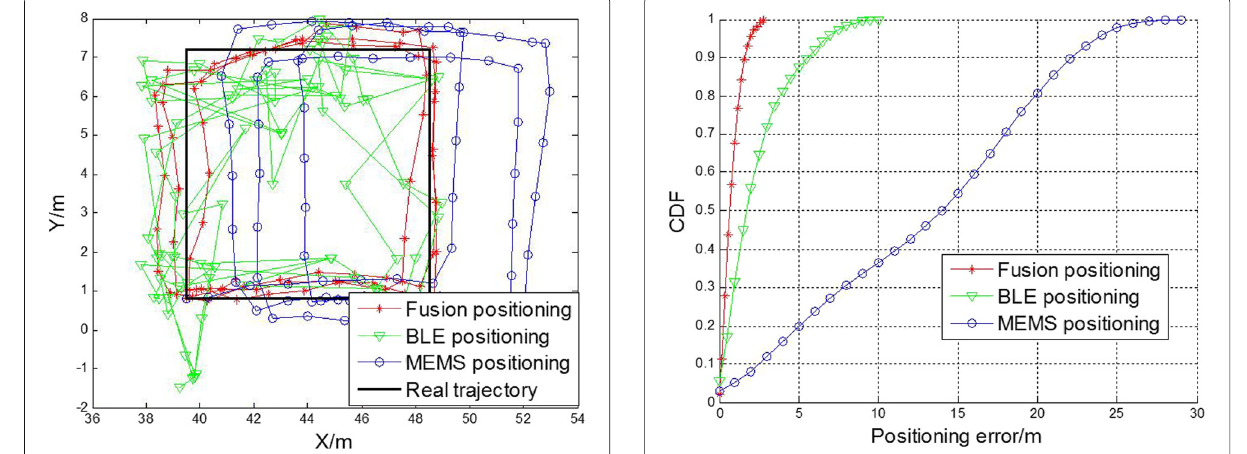
Fig. 34 CDF of positioning errors under linearshape of trajectory